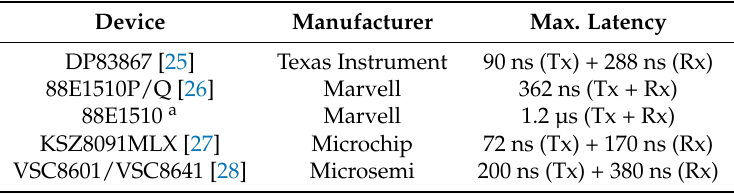
Table 1. Latency of PHYs operating at 100